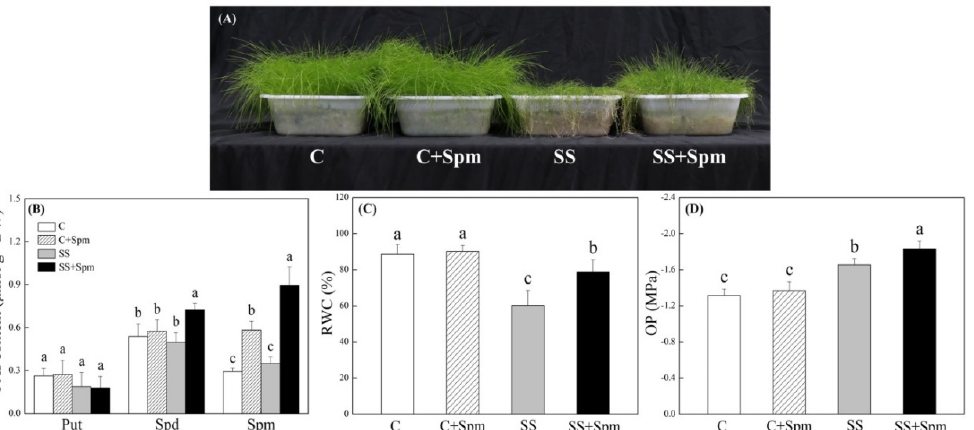
Figure 1. Effects of exogenous application of spermine (Spm) on ( A ) phonotypic changes, ( B ) en-dogenous polyamines (PAs), ( C ) relative water content (RWC), and ( D ) osmotic potential (OP) under normal conditions and salt stress. Vertical bars indicate ±SE of mean (n = 4). Different letters above columns indicate significant differences based on LSD ( p < 0.05). C, control; C + Spm, control + Spm; SS, salt stress; SS + Spm, salt stress + Spm.